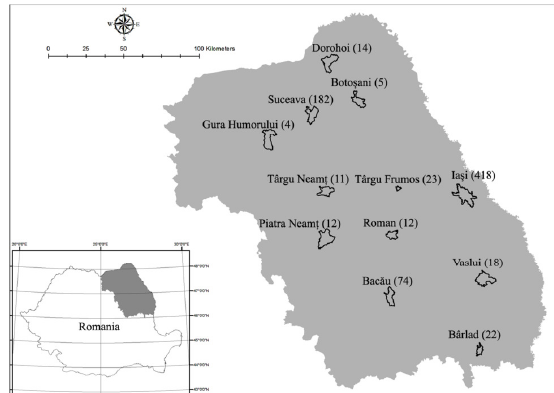
Fig. 1. Location of study area (the number of C. bignonioides trees investigated in each city is mentioned within brackets)